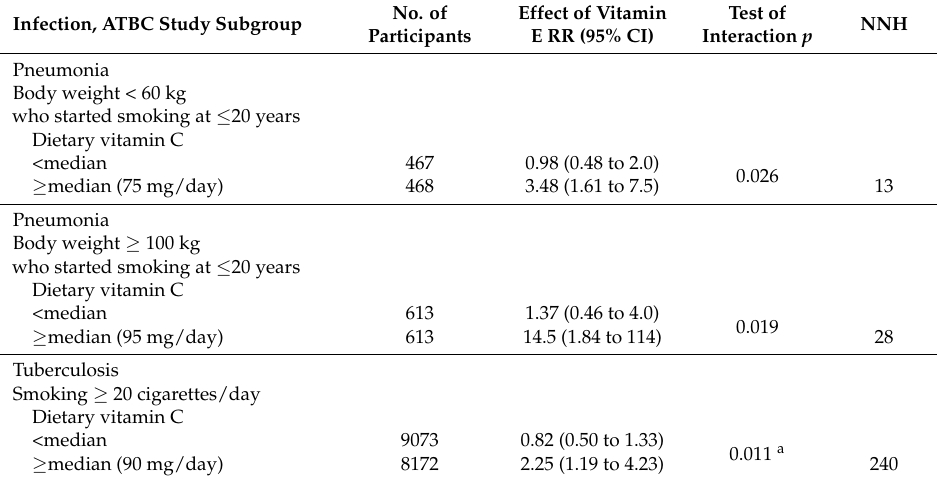
Table 8. Increase in pneumonia and tuberculosis risk with the combination of vitamins C and E. Infection, ATBC Study